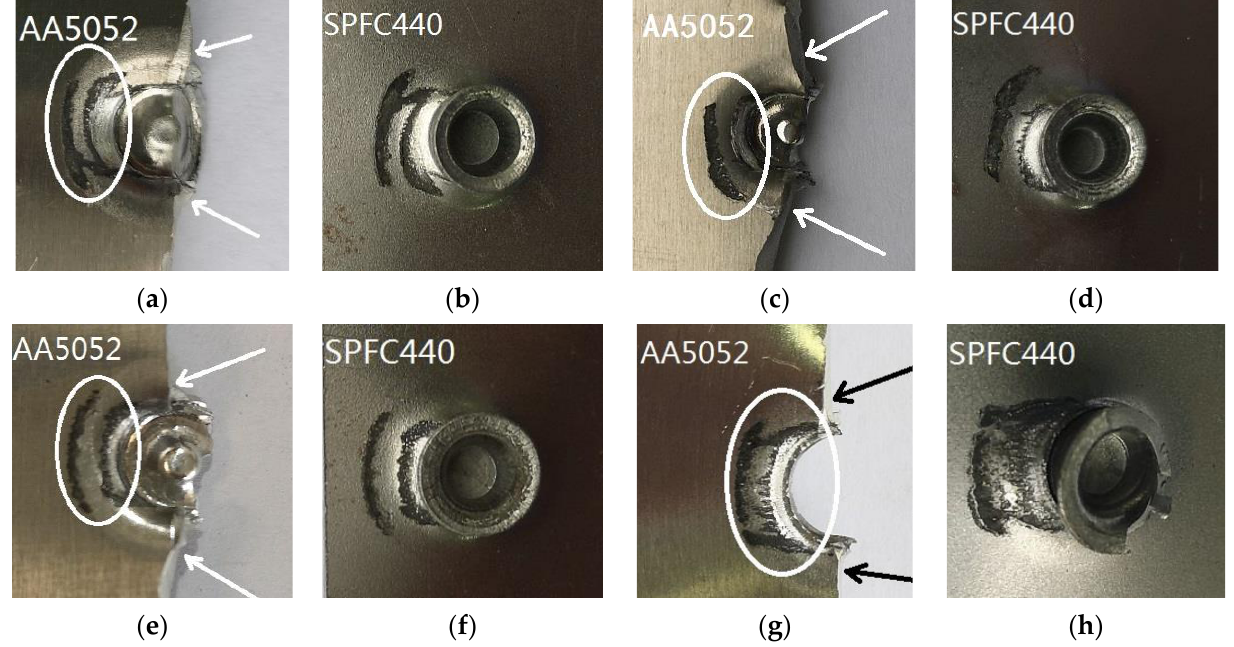
Figure 15. Wear morphologies of SPFC-AA joints: ( a ) AA5052 with 6 mm rivet; ( b ) SPFC with 6 mm rivet; ( c ) AA5052 with 7 mm rivet; ( d ) SPFC with 7 mm rivet; ( e ) AA5052 with 8 mm rivet; ( f ) SPFC with 8 mm rivet; ( g ) AA5052 with 9 mm rivet; ( h ) SPFC with 9 mm rivet.